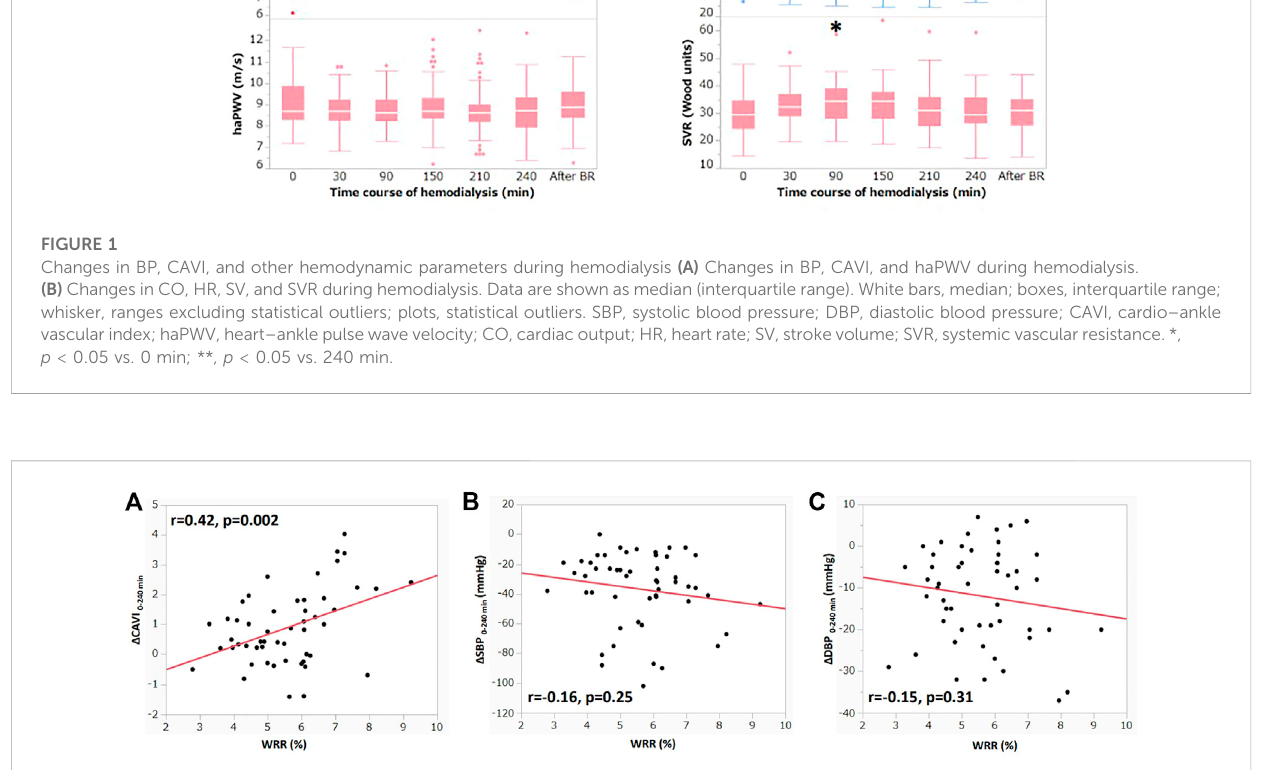
Correlation between Δ CAVI 0 – 240 min or Δ BP 0 – 240 min , and WRR during hemodialysis (A) Correlation between Δ CAVI 0 – 240 min and WRR during hemodialysis. (B) Correlation between Δ SBP 0 – 240 min and WRR during hemodialysis. (C) Correlation between Δ DBP 0 – 240 min and WRR during hemodialysis. r, Spearman ’ s correlation coef fi cient; CAVI, cardio – ankle vascular index; BP, blood pressure; WRR, water removal rate; SBP, systolic blood pressure; DBP, diastolic blood